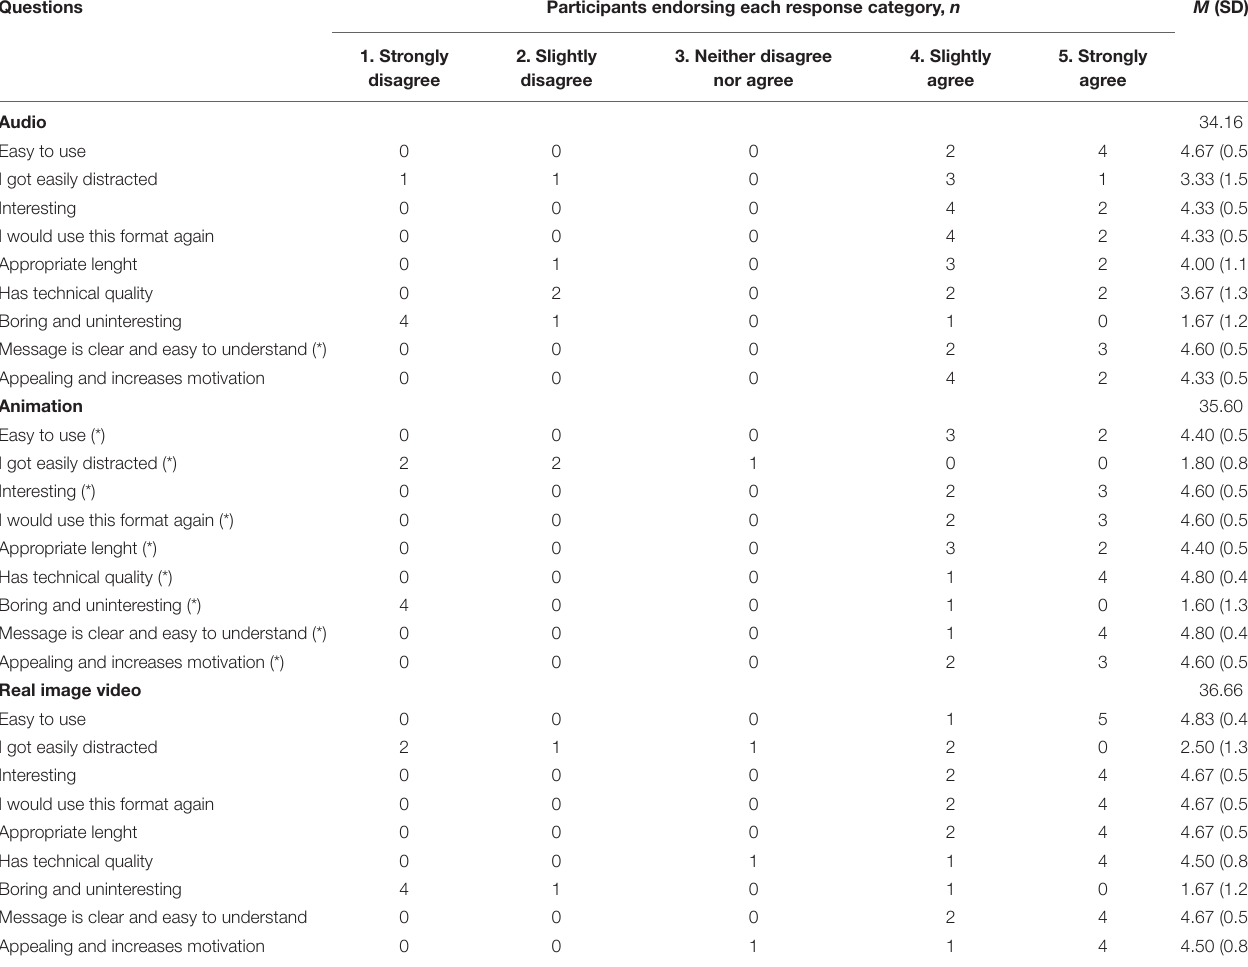
TABLE 2 | Participants’ feedback on the different kinds of content format ( n =